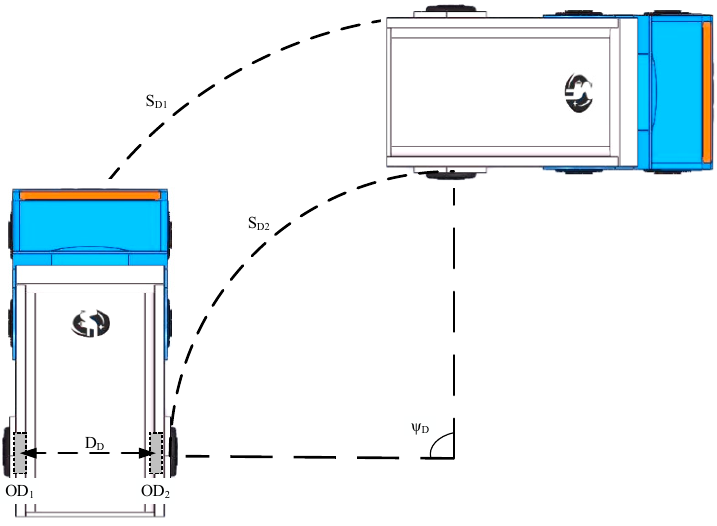
Figure 3. The azimuth of couple odometers.